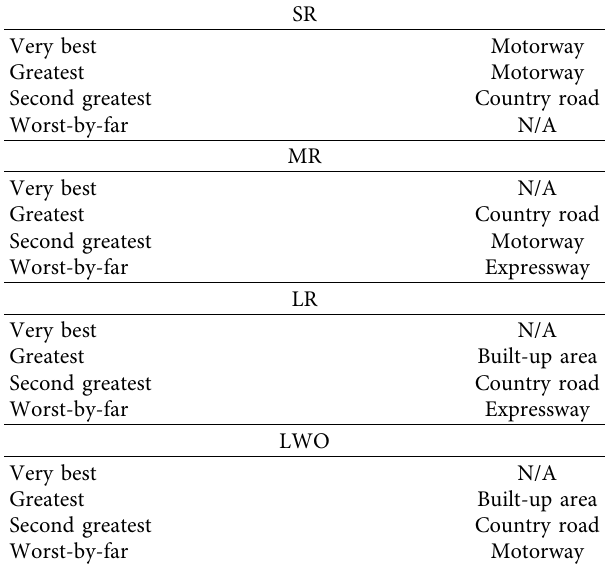
Table 8: Multiscale category values derived for the road location shown in Figure